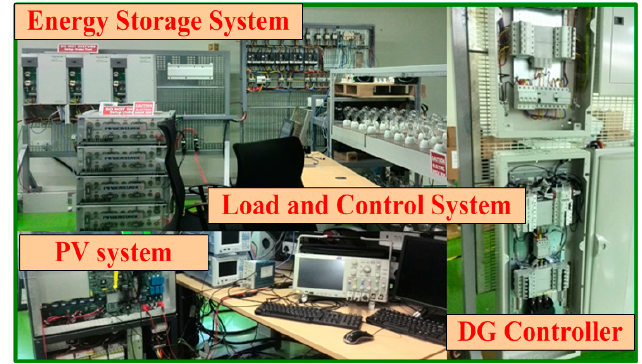
Figure 13. Experimental setup of the microgrid under consideration.